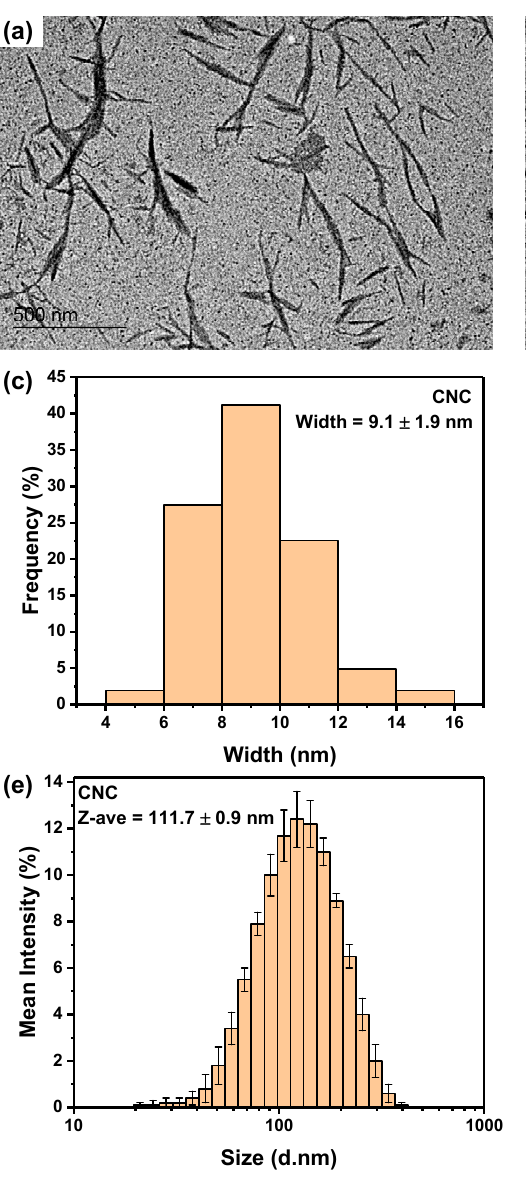
Figure 4. TEM images and the corresponding histograms of width distribution from TEM images: ( a , c ) CNC and ( b , d ) DCNC; size distribution histogram of ( e ) CNC and ( f ) DCNC measured by DLS.